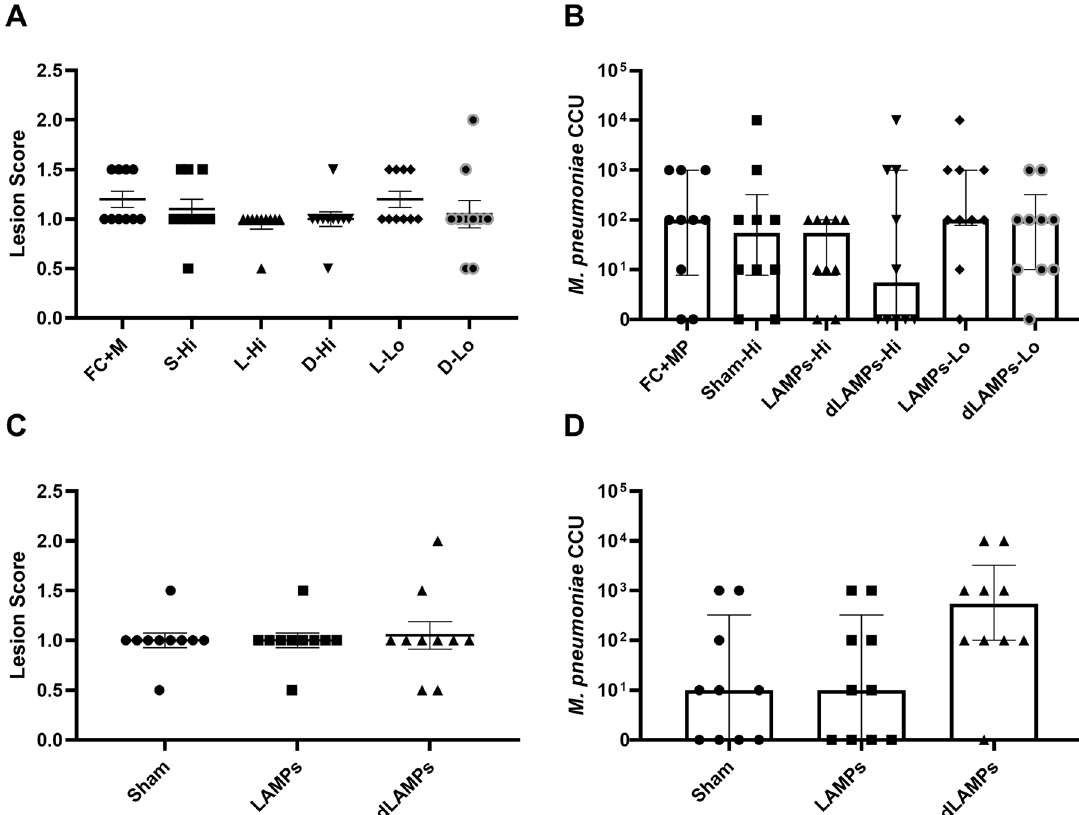
Fig. 2 Passive transfer of hyper-immune sera to naïve mice. A Histopathologic scoring of lungs from mice intranasally inoculated with Lipid- associated Membrane Protein-induced (LAMP), delipidated Lipid-associated Membrane Protein-induced (dLAMP) or naïve-mouse (sham) serum at high (Hi) or low (Lo) concentration and challenged with M. pneumoniae . Data were compared by Kruskal – Wallis test with Dunn ’ s post- hoc test used for multiple comparisons. B Bacterial recoveries from the lungs of mice intranasally inoculated with vaccine-induced or naïve- mouse (Sham) serum at high or low concentration and challenged with M. pneumoniae . Data are displayed as median with interquartile range, and were compared by Kruskal – Wallis test with Dunn ’ s post-hoc test used for multiple comparisons. C Histopathologic scoring of lungs from mice intraperitoneally inoculated with vaccine-induced or naïve-mouse (sham) serum and challenged with M. pneumoniae . Data were compared by Kruskal – Wallis test with Dunn ’ s post-hoc test used for multiple comparisons. D Bacterial recoveries from the lungs of mice intraperitoneally inoculated with vaccine-induced or naïve-mouse (Sham) serum and challenged with M. pneumoniae . Data are displayed as median with interquartile range, and were compared by Kruskal – Wallis test with Dunn ’ s post-hoc test used for multiple